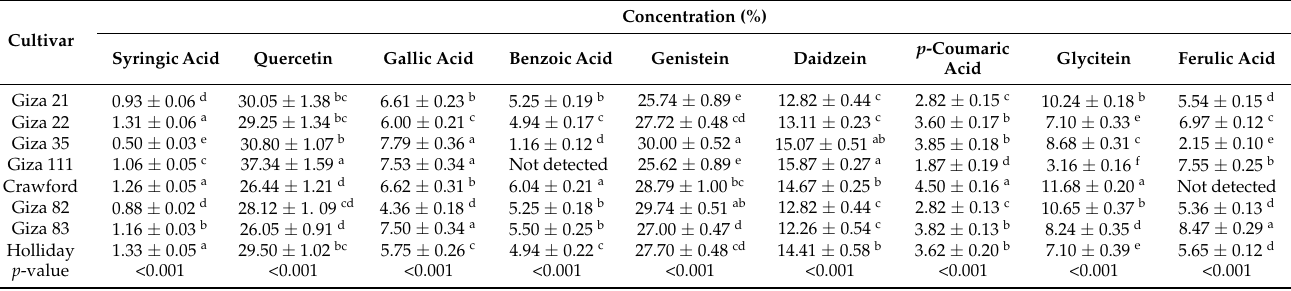
Table 3. Major phenolic, flavonoid, and isoflavone compounds in the eight soybean cultivar extracts estimated by